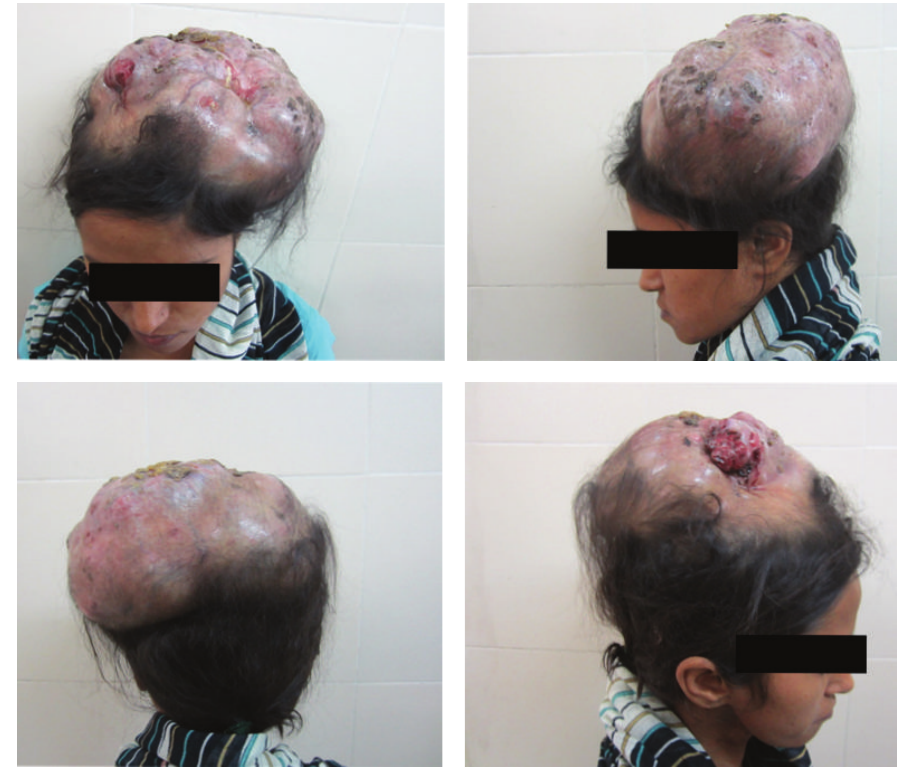
Figure 1: The large bosselated tumour covering almost the whole scalp with multiple ulcers and pus pockets.